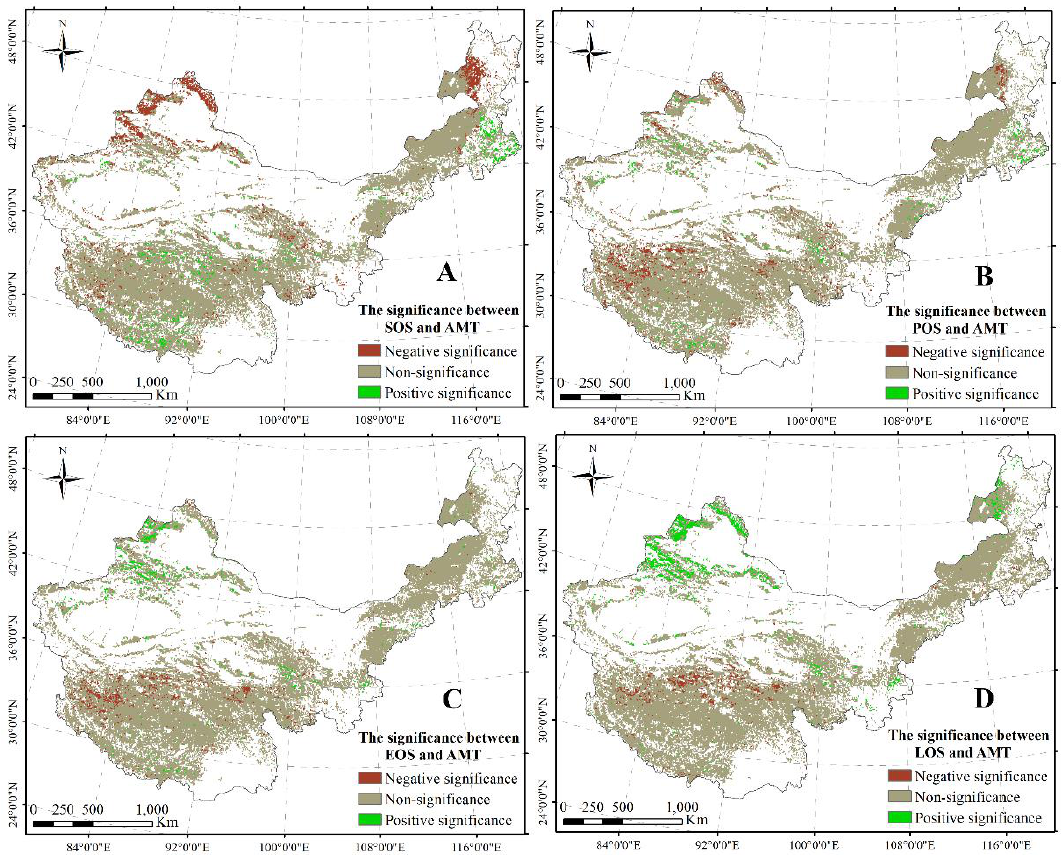
Figure 5. Significant correlations between SOS and AMT ( A ); between POS and AMT ( B ); between EOS and AMT ( C ); and between LOS and AMT ( D ). The significance level is 0.05.